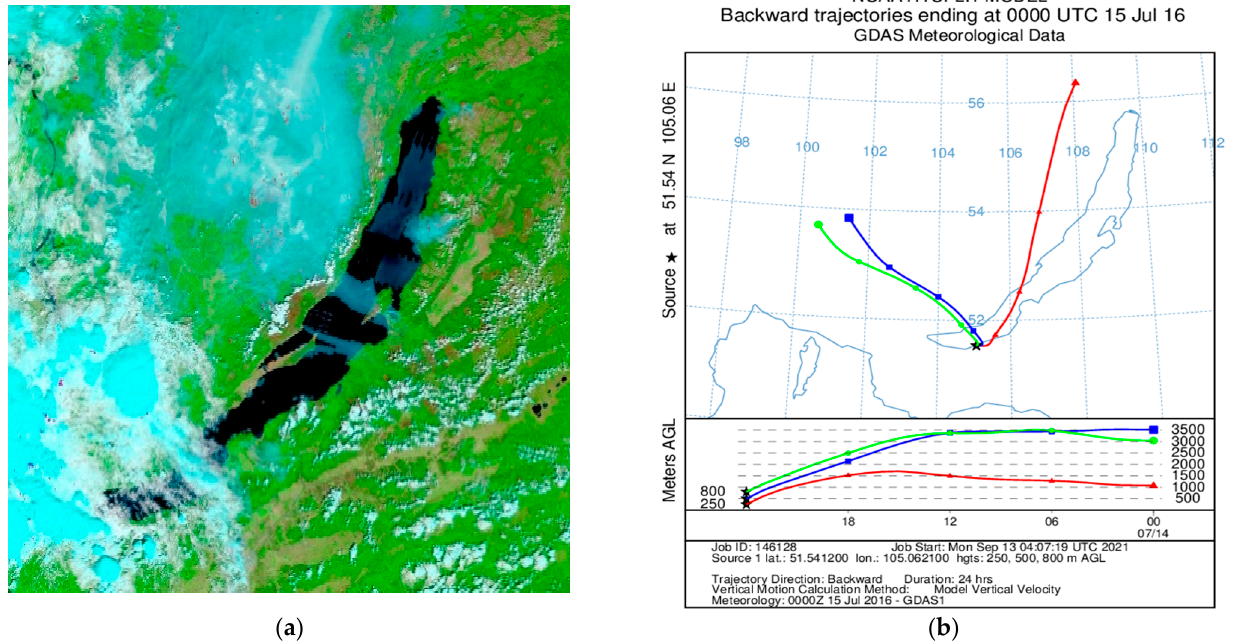
Figure 4. The wildfires in Siberia in July 2016: ( a ) Satellite image on 28 July 2016 [57]; ( b ) Back trajectories of air mass transport to the southern basin of Lake Baikal.